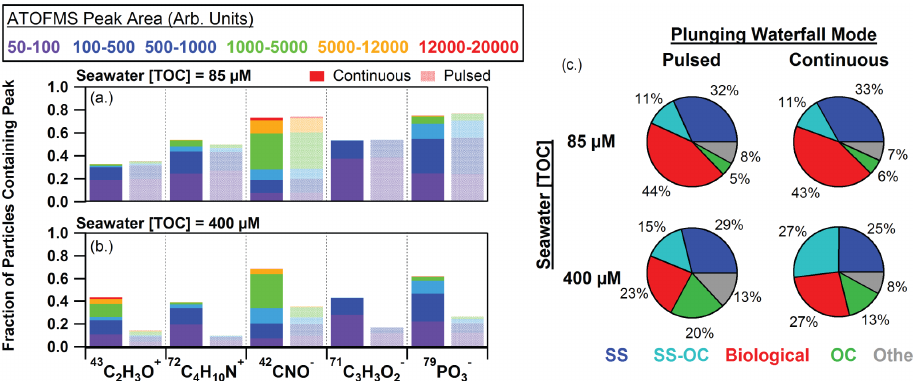
Figure 8. (a, b) Comparison of color-stack plots generated by sampling SSA produced by a plunging waterfall under “continuous” bubble generation versus “pulsed” (4s on/off) bubble generation. Large differences in SSA composition are observed when seawater organic matter concentrations are high ([TOC] = 400µM), coinciding with major differences in surface foam accumulation between the generation modes. Only SS-OC particles are considered in (a) and (b) . On the right, (c) shows a matrix of pie charts indicating the fractional contribution of each of the particle types to SSA from both pulsed and continuous plunging with both low (85µM) and high (400µM) organic matter concentrations in the seawater.